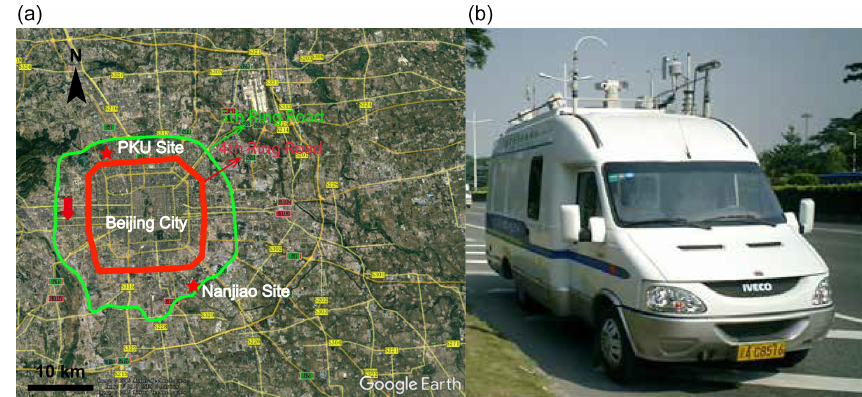
Figure 1. The measurement route (a) and the mobile measurement platform (b) . The route started from the Peking University (PKU), driving counter-clockwise around (indicates by the red arrow) the 4th Ring Road of Beijing (circumference ∼ 65km) before returning to PKU. The red line represents the 4th Ring Road of Beijing, the green line represents the 5th Ring Road, and the red stars show the ground-based observation sites (PKU and Nanjiao). The map was created by © Google Earth (version: Google Earth Map,